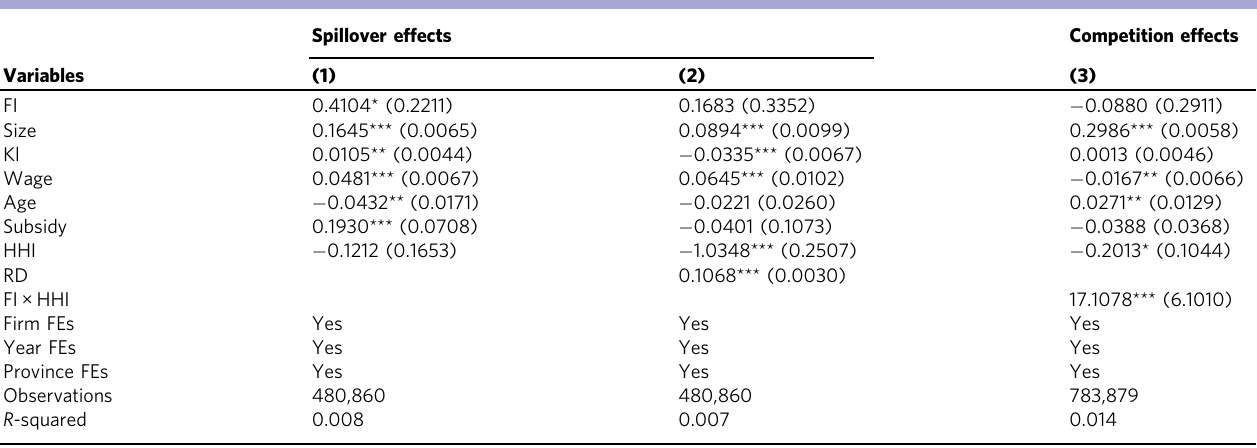
Table 4 In fl uence channel